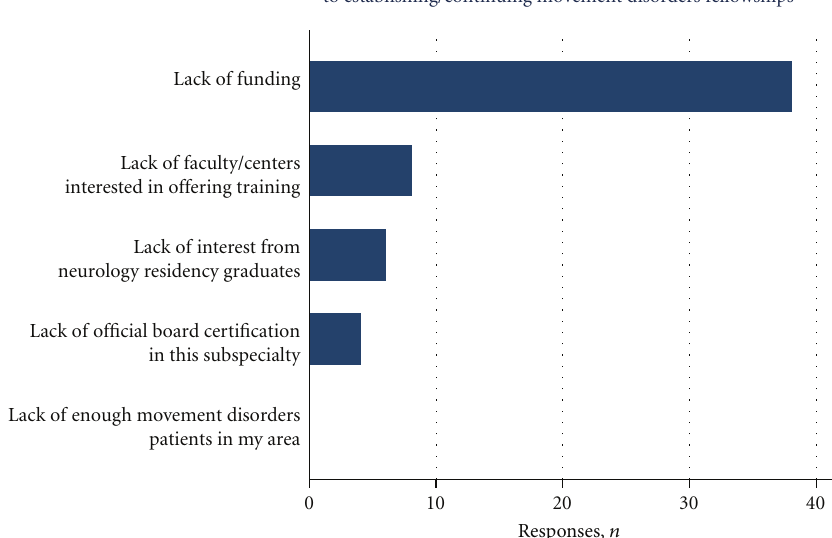
Figure 6: Areas of greatest concern identified by program directors with respect to maintaining fellowship training